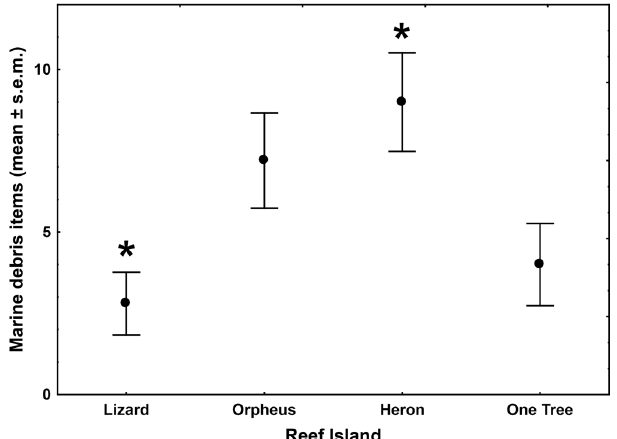
Figure 5. Mean number of marine microdebris items in juvenile coral trout per reef island. The average number ( ± s.e.m.) of marine microdebris items detected in the gastrointestinal tracts of five juvenile coral trout ( Plectropomus leopardus and P. maculatus ) at each of the four reef islands in the Great Barrier Reef World Heritage Area, Australia. Fish were collected in 2011.